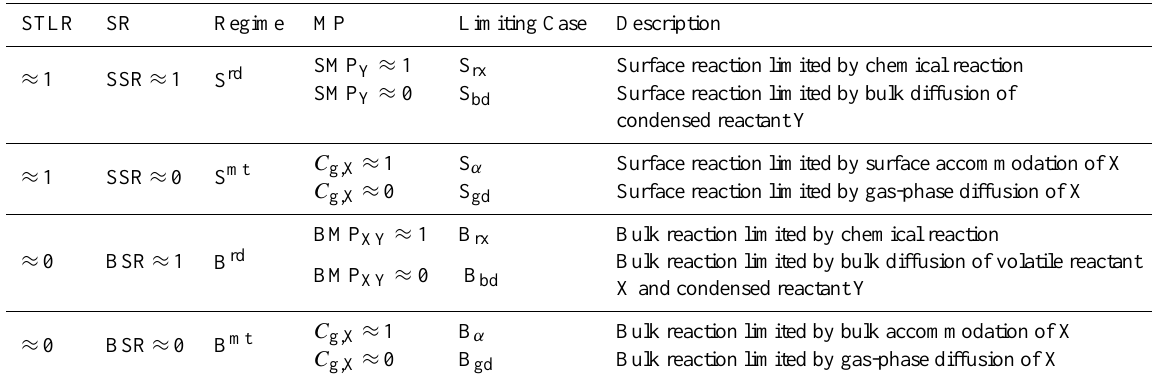
Table 1. The principle regimes and limiting cases, defined in terms of two and three classification parameters, respectively. The classification properties are the surface to total loss rate ratio (STLR), the saturation ratio(s) (SR) and the mixing parameter(s) (MP). When more than one expression for a classification property is possible (SR/MP), the expression is listed along with a rough criterion. STLR